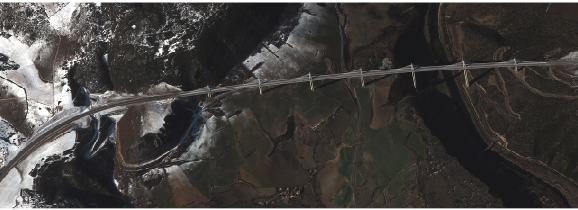
Figure 9: Pleiades-HR sensor image of Viaduc de Millau,